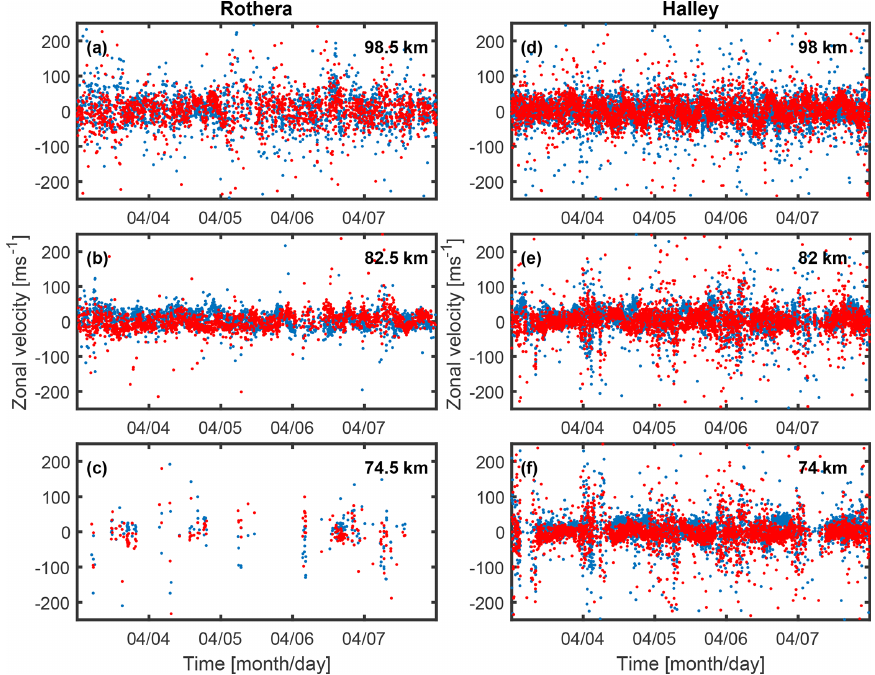
Figure 2. Sample data from the Rothera (a–c) and Halley (d–f) radars for three comparable heights from 3 to 7 April 2013. Blue dots represent zonal winds; red dots represent meridional winds. Large variability can be seen in each plot. At the lowest altitude, Rothera (c) experiences a loss of scatter due to a weaker (than Halley, f ) returned signal.